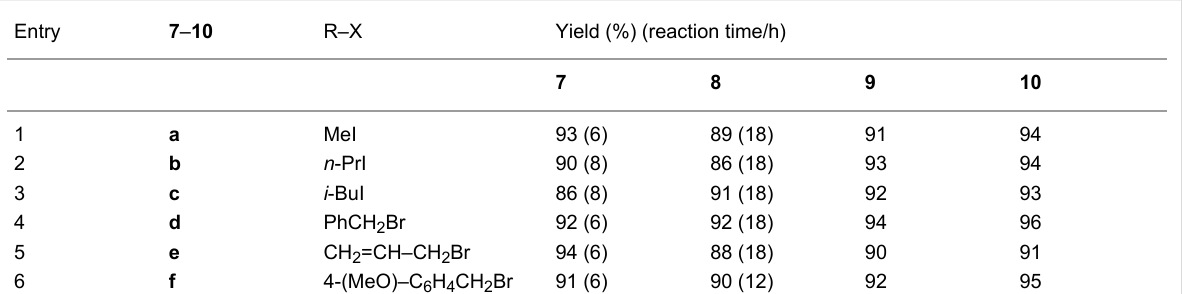
Table 3: Percentage yields of intermediate and final products of the transformation of 6 to 10 (Scheme 2) along with reaction times for their formation. a